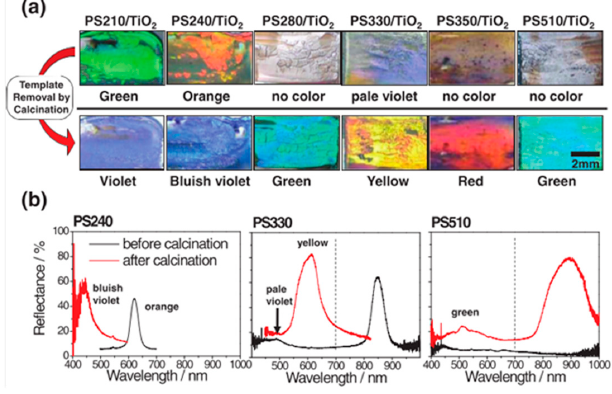
Figure 14. ( a ) Photographs of composite Polystyrene/TiO 2 films templated with different sizes of PS microspheres and the corresponding TiO 2 inverse opal films after calcination. ( b ) Reflectance spectra